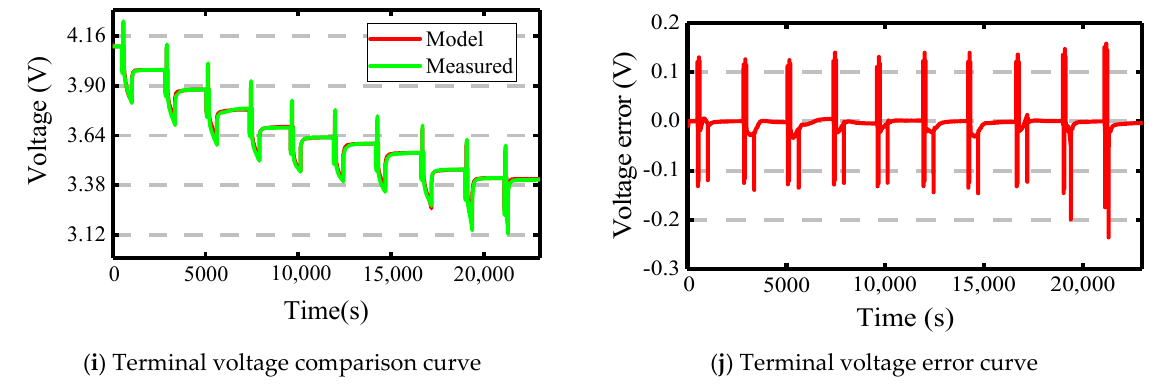
Figure 7. Full parameter identification result based on the IR-PCM model.